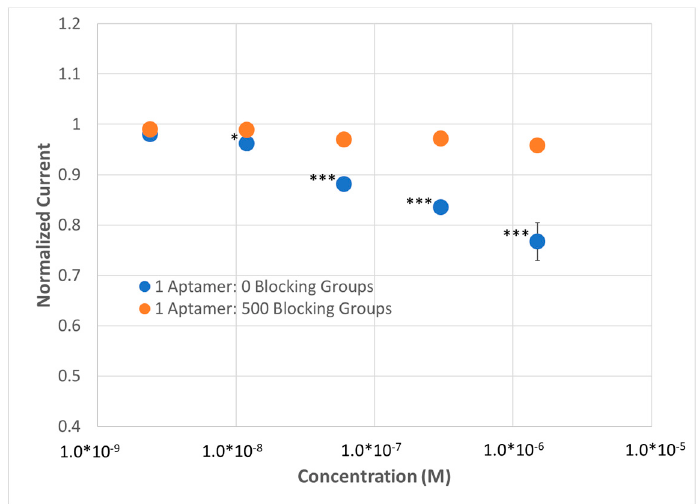
Figure 6. Demonstration of lysozyme aptasensor (n = 4) with a 6-carbon zwitterionic SAM (C6 +/ − ) measured using SWV at 10 Hz in 1 × HBS containing 10 mM ferricyanide redox reporter. p values < 0.05 using SWV at 10 Hz in 1 × HBS containing 10 mM ferricyanide redox reporter. P values < 0.05 (*), 0.01 (**) and (*), 0.01 (**) and 0.001 (***) determined using a two-tail t 0.001 (***) determined using a two-tail t-test.